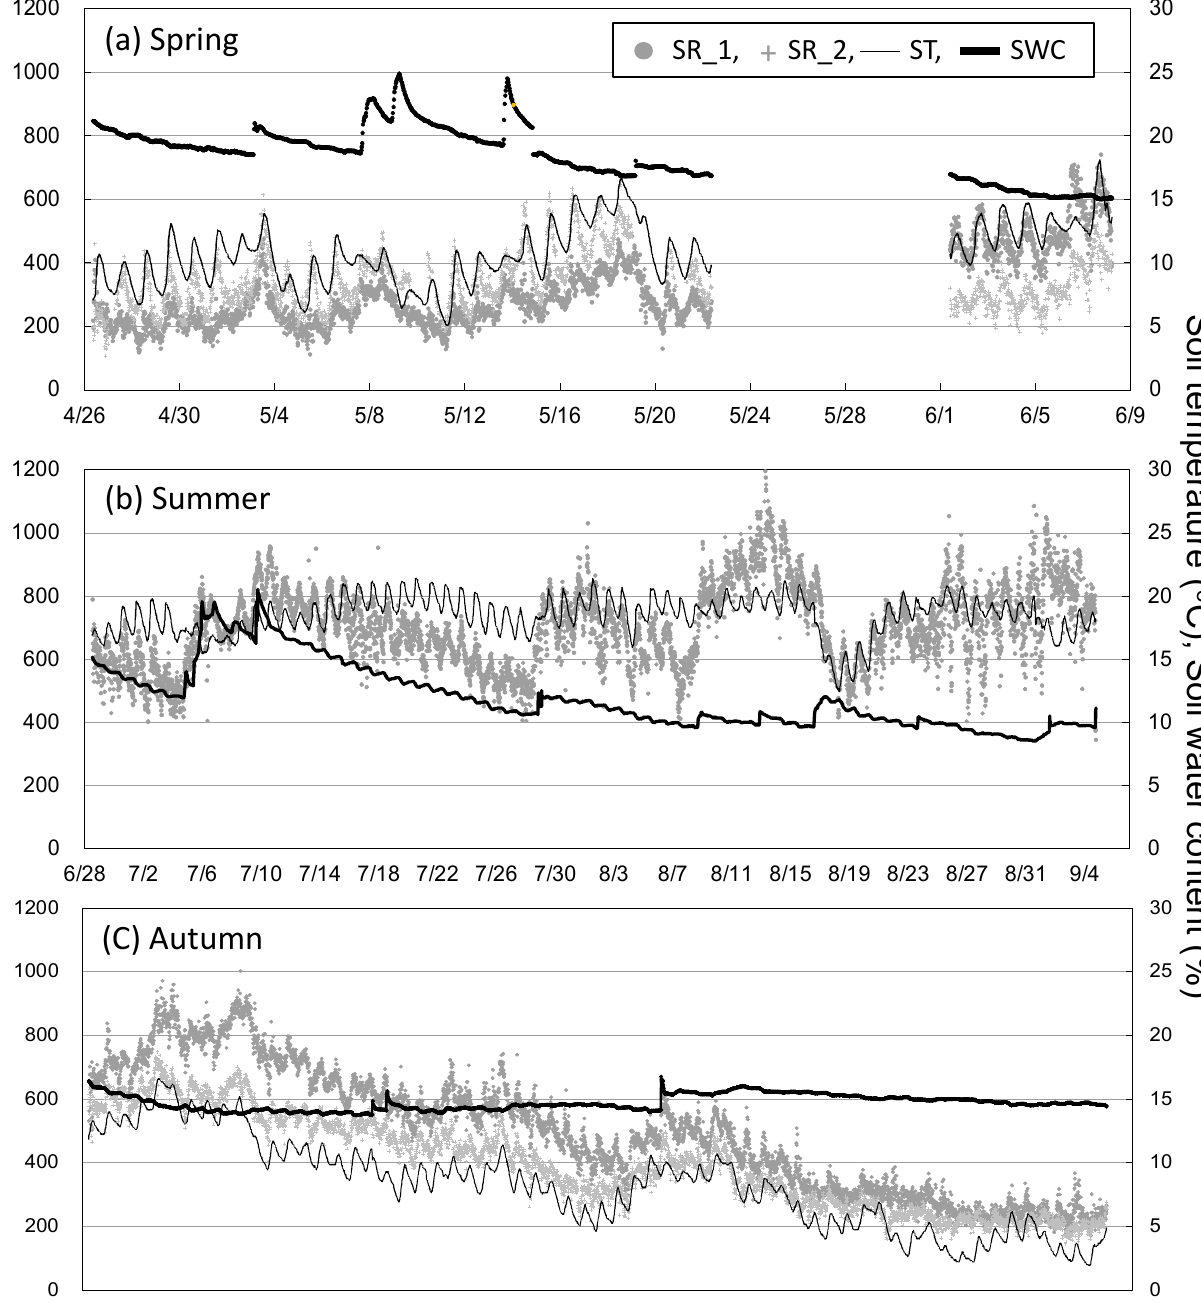
Figure 2. Relationship between soil respiration rate and soil temperature at a depth of 5 cm in the two chambers. Closed black circles, spring; open gray triangles, summer; closed gray circles, au- tumn.